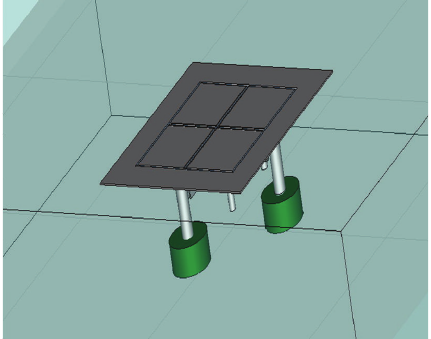
Figure 5: Single element 3D view.